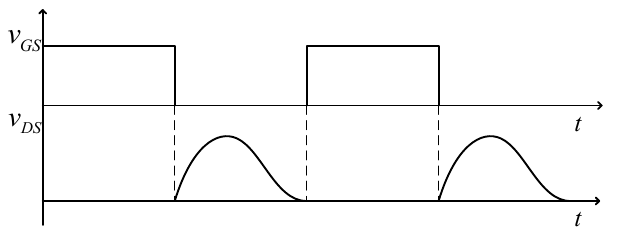
Figure 2. Zero voltage switching (ZVS) and zero derivative switching (ZDS) soft-switching waveforms of Class-E inverter.